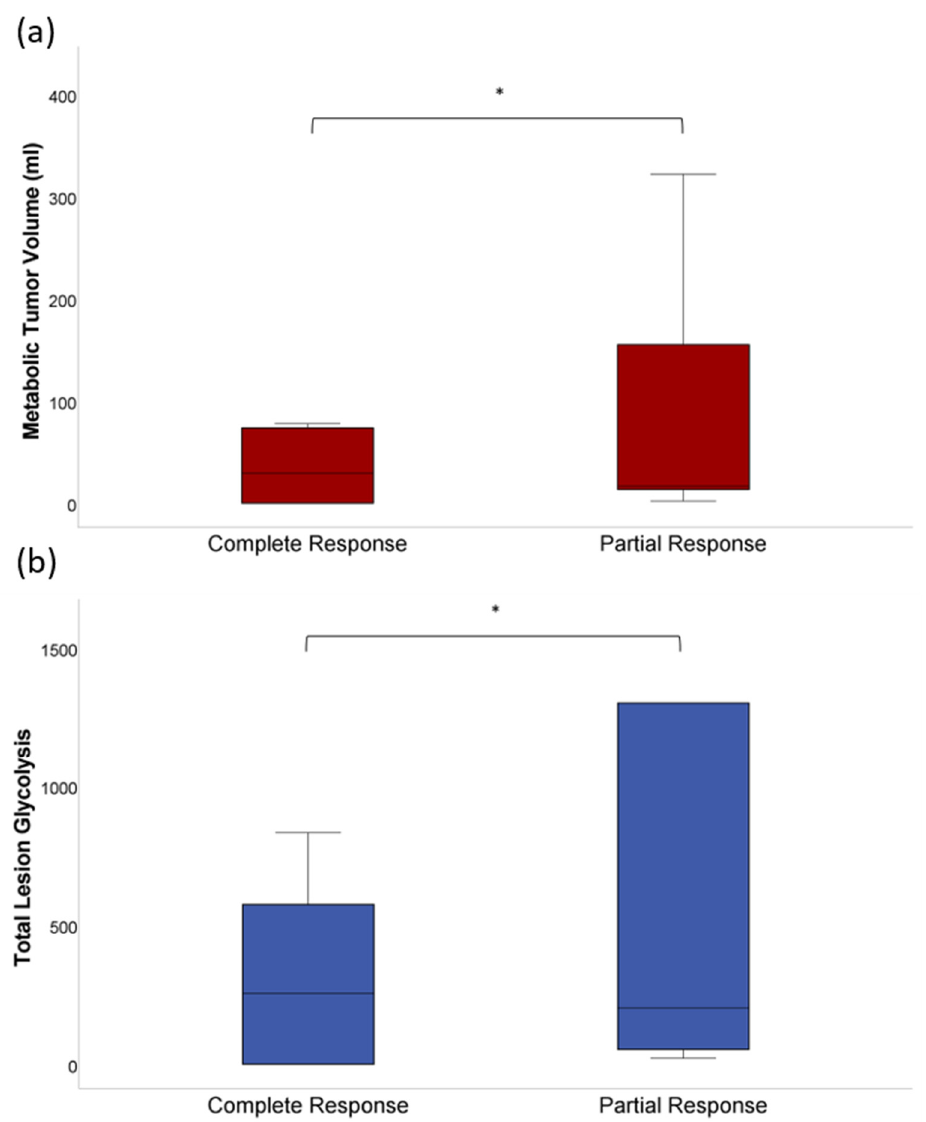
Figure 1. ( a ) At baseline 18 F-FDG PET/CT before CAR-T cell therapy, both the whole-body MTV (35 ± 38 mL vs. 88 ± 110 mL) and ( b ) the whole-body TLG (319 ± 362 vs. 1488 ± 2254) were lower in patients achieving CR compared to patients achieving PR ( p < 0.01 and p < 0.05). The asterisk (*) indicates clinical significance ( p < 0.05).